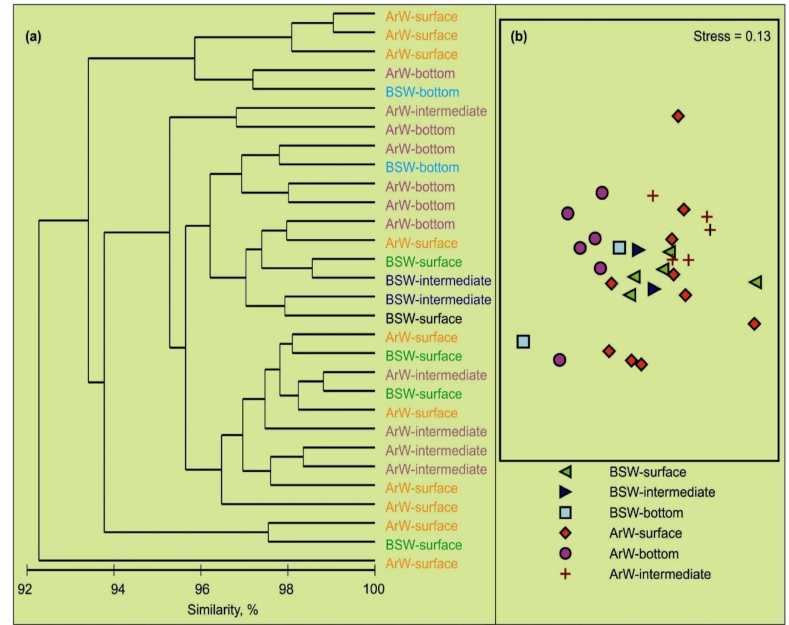
Figure 6. Cluster dendrogram ( a ) and NMDS ordination plot ( b ), showing relationships between stations, based on microbial parameters in the northeastern Barents Sea, in October 2020. Water masses: BSW—Barents Sea Water, ArW—Arctic